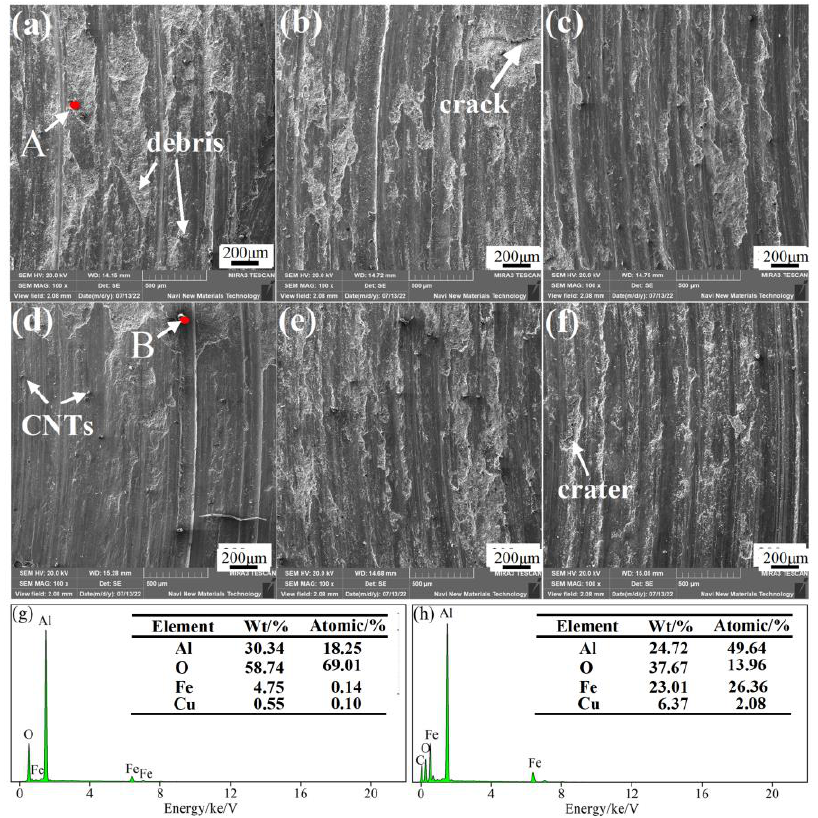
Figure 15. SEM micrographs of representative worn surfaces of x % CNTs /Al-Cu-Mg-Si under 200 °C: ( a ) 0 wt%, ( b ) 0.5 wt%, ( c ) 1.0 wt%, ( d ) 1.5 wt%, ( e ) 2.0 wt%, ( f ) 3.0 wt%. ( g ) EDS result of point A, ( h ) EDS result of point B.